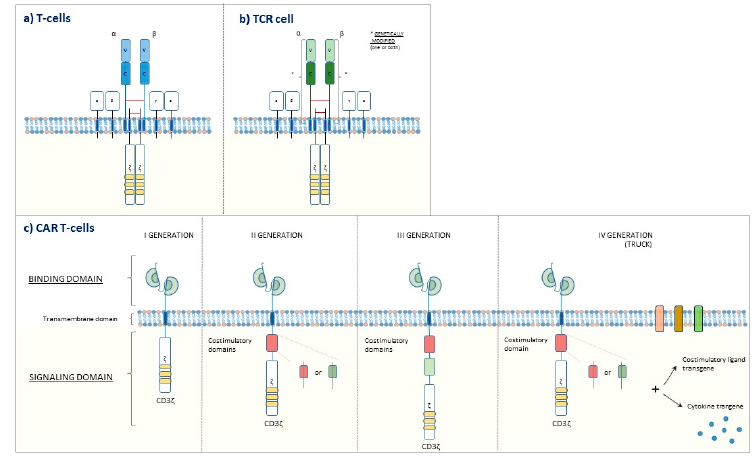
Figure 2. ( a ) T-cell receptor on the surface of T cell, ( b ) engineered T-cell receptor on the surface of engineered T cell (TCR cell), ( c ) Four generations of chimeric antigen receptor (CAR) T cells. I generation: the intracellular signaling domain alone (CD3 ζ -chain). II generation: one costimulatory domain and the intracellular signaling domain. III generation: two costimulatory domains and the intracellular signaling domain. IV generation: costimulatory domain(s), the intracellular signaling domain, and activity enhancing factors (e.g., cytokines, co-stimulatory ligands).